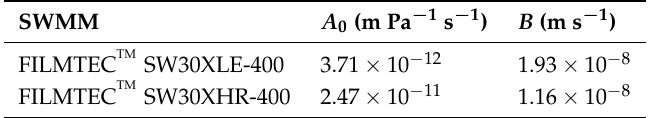
Table 1. SWRO membrane permeability coefficients under test